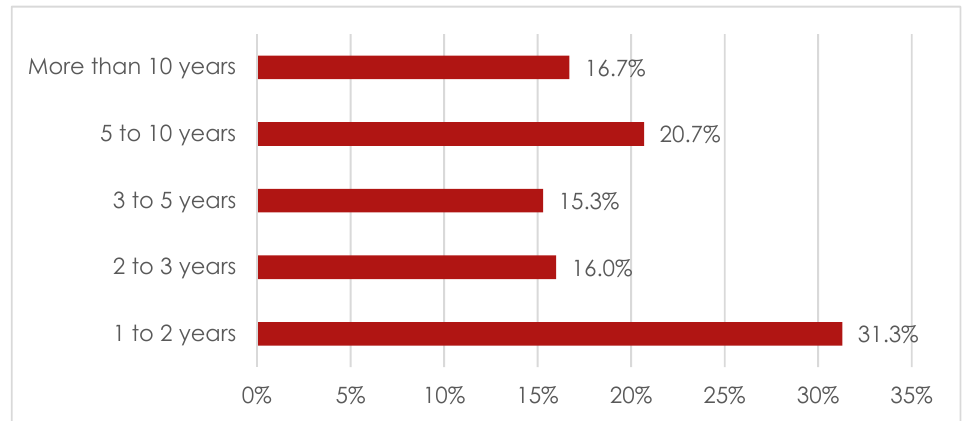
Figure 1. Graphic representation of yoga practice experience among practitioners.